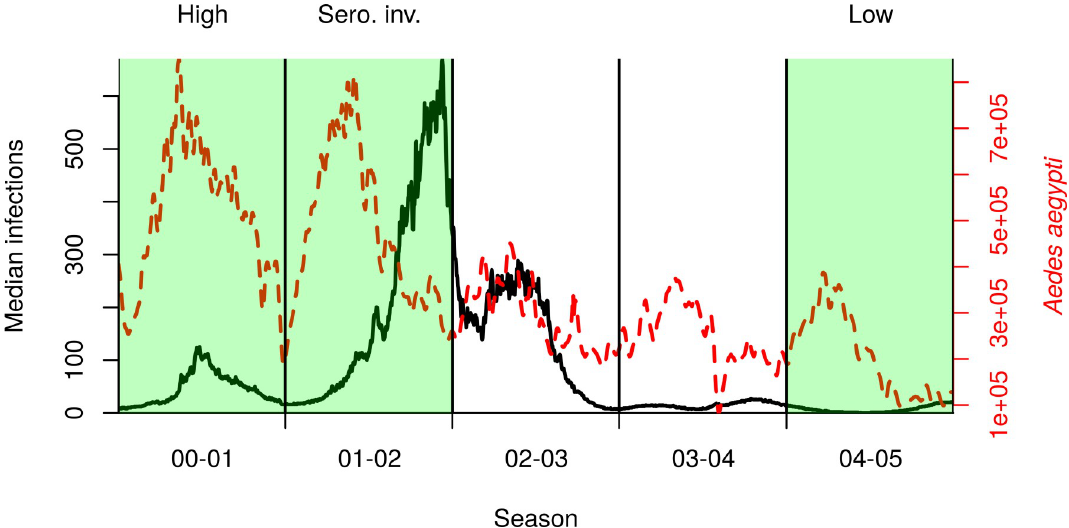
Fig 1. Median incidence of DENV infections (black solid line) and total mosquito abundance (dashed red line) in our reconstruction of dengue virus transmission during 2000–2005 in Iquitos. Vertical lines delineate transmission seasons, defined as beginning on July 1. Highlighted in green are three seasons in which we initiated lockdown, chosen to represent a range of possible epidemiological scenarios.